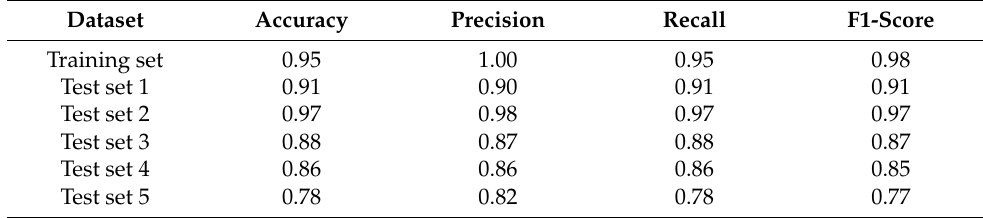
Table 7. Summary of evaluation results for IF.